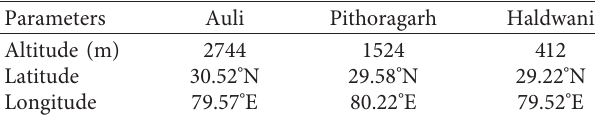
Table 1: Geographical data of cultivation sites.